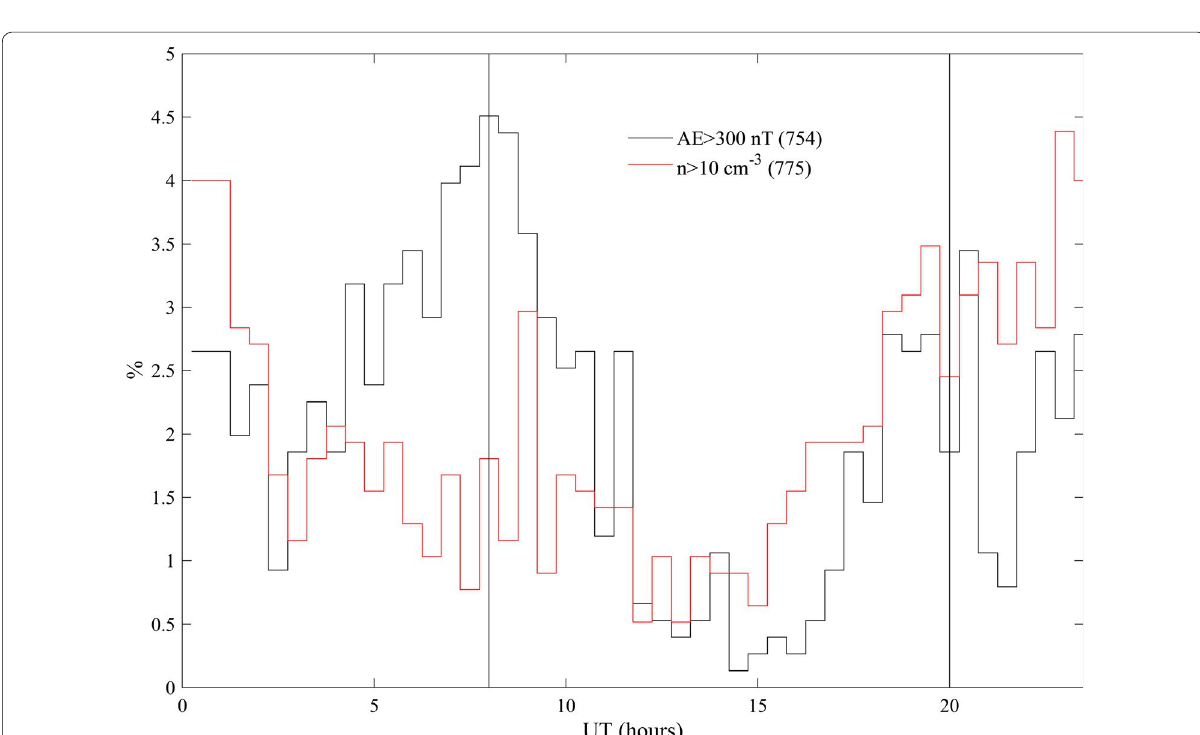
Fig. 9 ULF dependence on AE and solar wind density. The UT distribution of the events for disturbed geomagnetic conditions (black line) and high SW densities (red line). The vertical lines at approximately 08 UT and 20 UT indicate the magnetic midnight and noon,